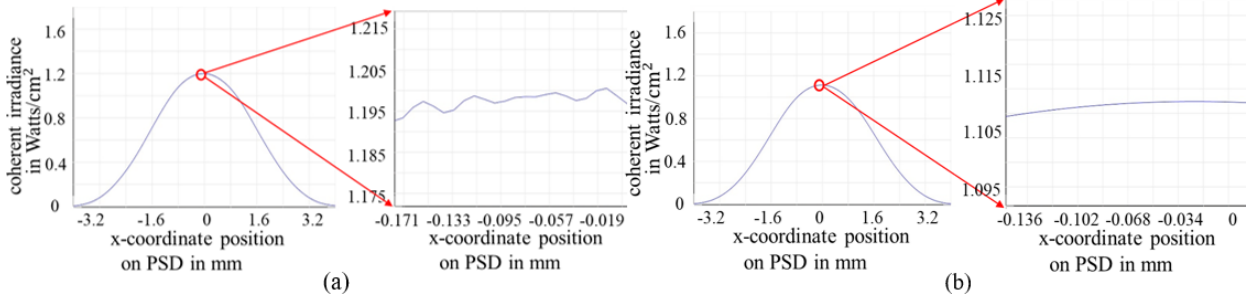
Figure 2. Lateral distribution of the coherent irradiance on the PSD (one cross section) of the previous system (a) and the new system (b) .